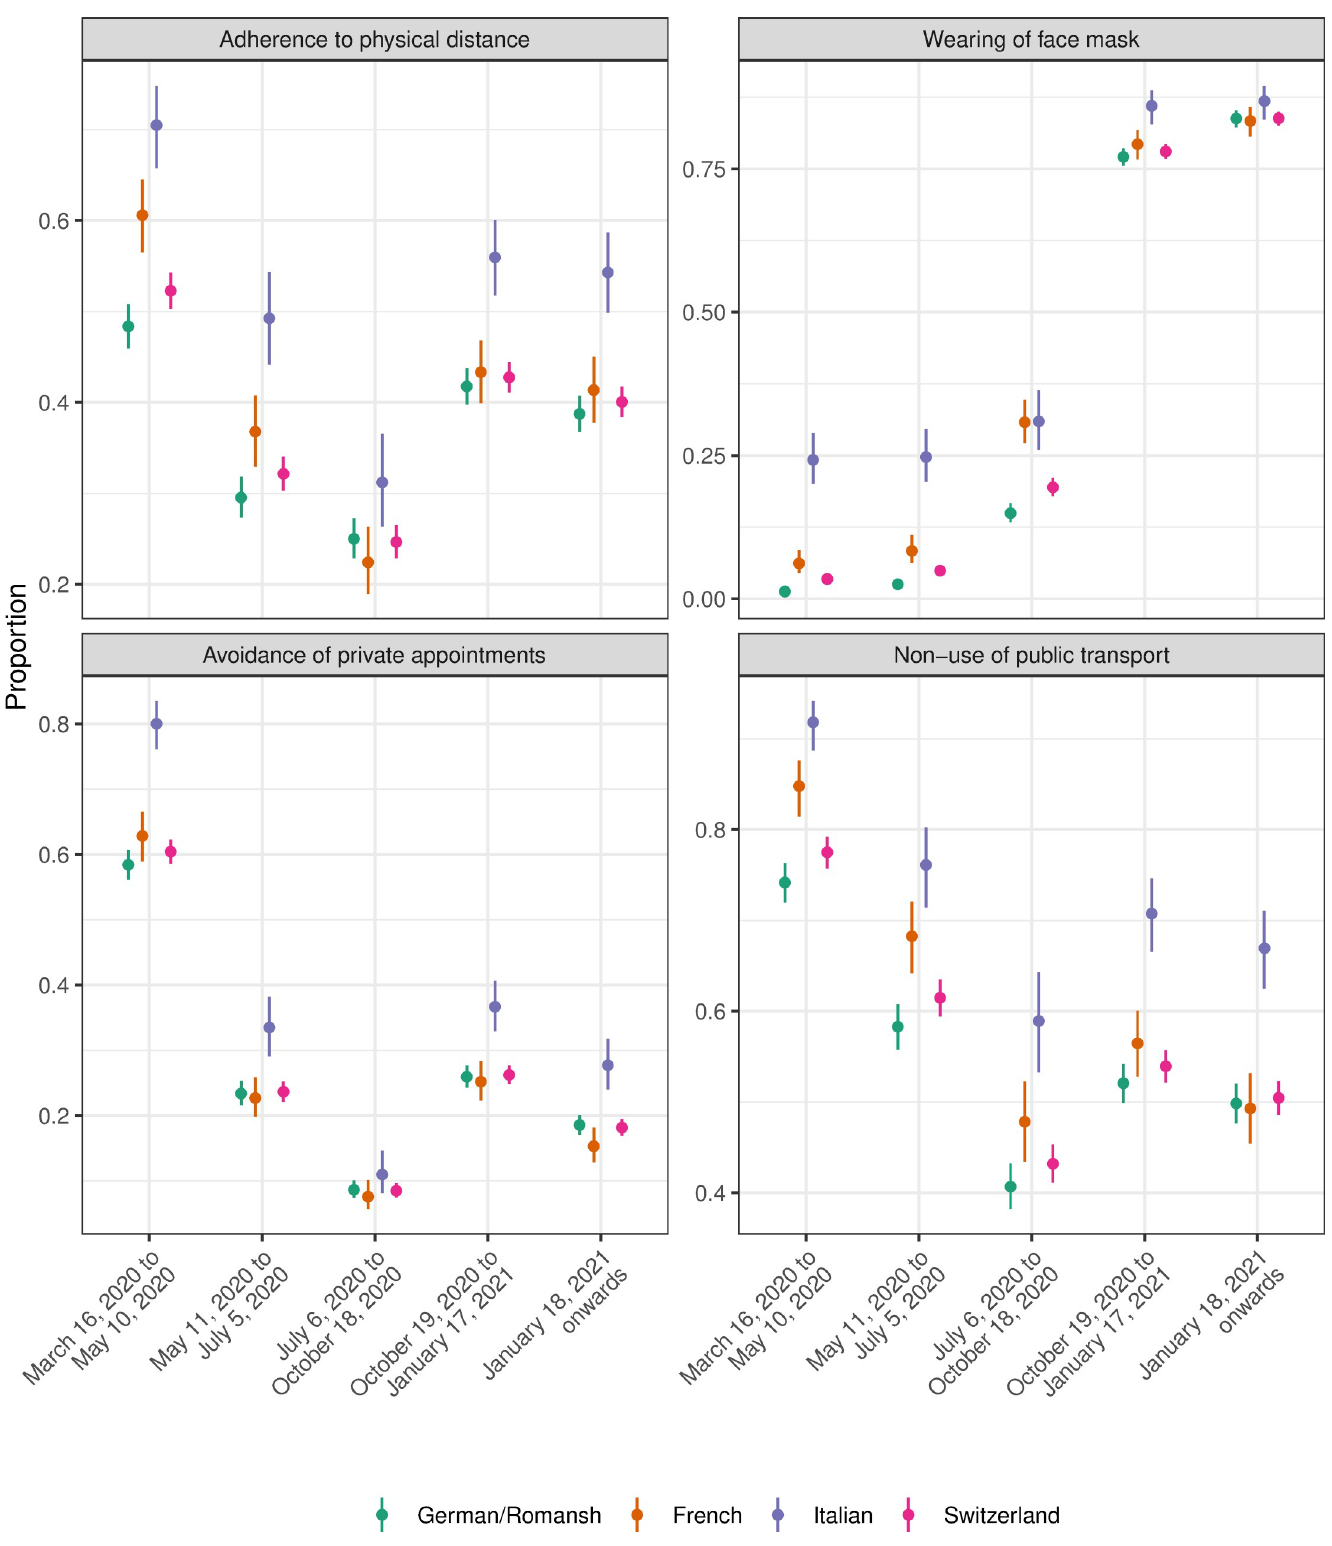
Fig 5. Proportion of study outcomes for the domain of adherence to mitigation measures, by mitigation period, language region and for the whole of Switzerland.